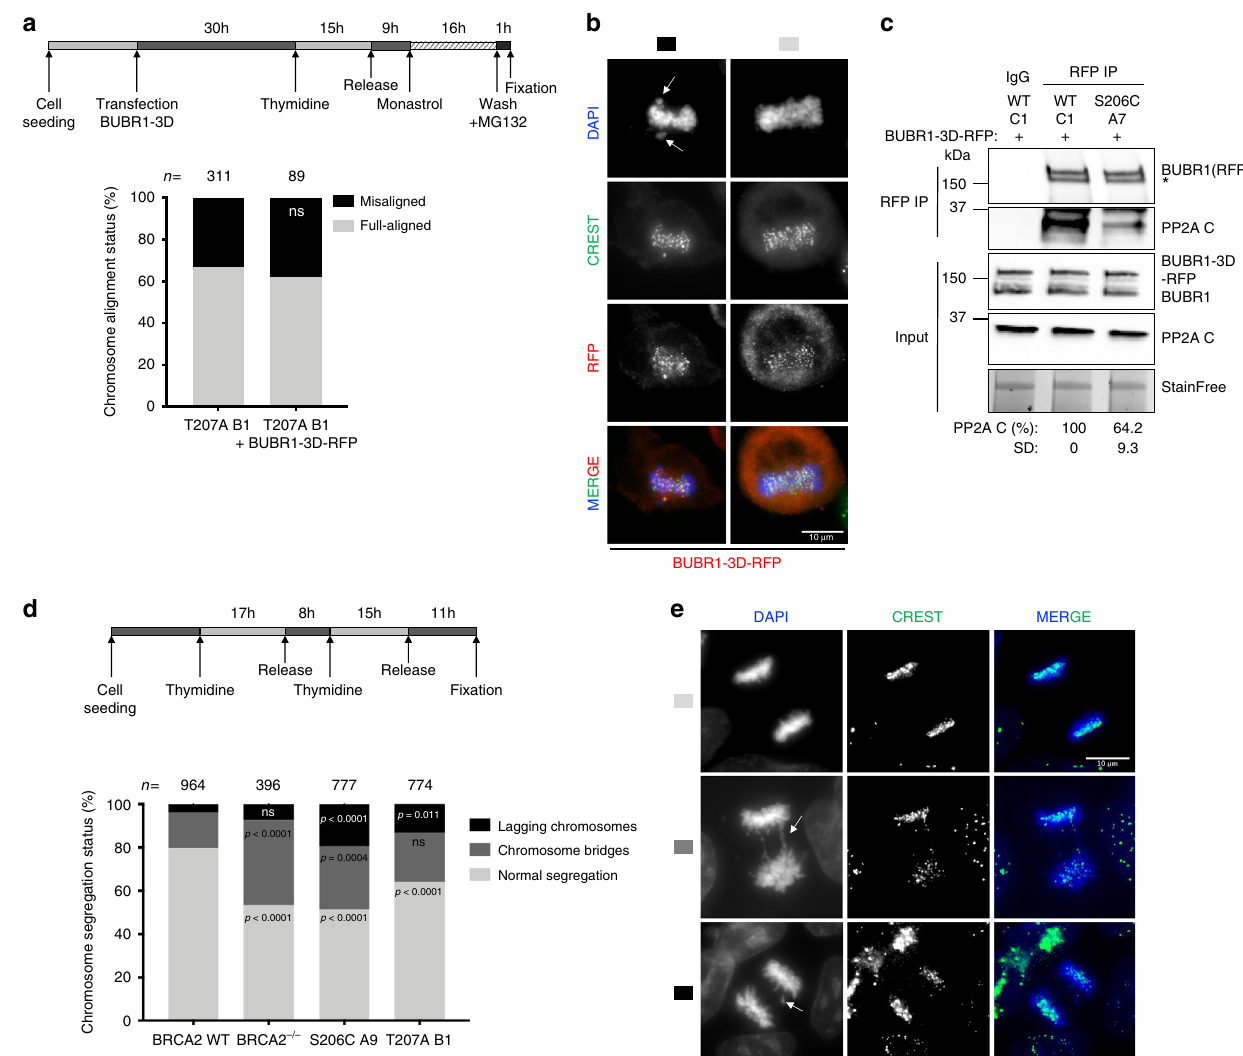
Fig. 7 Cells expressing BRCA2 variants S206C and T207A display aberrant chromosome segregation. a Top: Scheme of the synchronization procedure. Bottom: Quanti fi cation of misaligned chromosomes in BRCA2-T207A stable clones transiently overexpressing the 3xFLAG-BUBR1-3D-RFP mutant (S670D, S676D and T680D). n indicates the total number of cells counted from two independent experiments. Unpaired two-tailed t -test was used to calculate statistical signi fi cance of differences, ns (non-signi fi cant)). b Representative images of the type of chromosome alignment observed in cells overexpressing 3xFLAG-BUBR1-3D-RFP quanti fi ed in ( a ); scale bar represents 10 µ m. c Co-immunoprecipitation of endogenous PP2A with transiently overexpressed 3xFLAG- BUBR1-3D-RFP mutant from mitotic cell extracts of BRCA2 WT cells or cells bearing the S206C variant using rabbit anti-RFP antibody. Rabbit IgG was used as control for the BUBR1 immunoprecipitation. The immunocomplexes were resolved on 4 – 15% SDS-PAGE followed by WB using mouse anti-BUBR1 and PP2AC antibodies. The amount of PP2A co-immunoprecipitated with BUBR1-3D-RFP relative to the input levels of PP2A and the amount of immunoprecipitated BUBR1- 3D-RFP is presented below the blot as mean ± SD from two independent experiments. The data are presented relative to the non-treated BRCA2 WT. Asterisk denotes a non-speci fi c band ( d ). Top: Scheme of the synchronization procedure. Bottom: Quanti fi cation of cells with aberrant chromosomes segregation in BRCA2 − / − cells and in the clones stably expressing BRCA2 WT, S206C and T207A, as indicated. Two-way ANOVA test with Tukey ’ s multiple comparisons test was used to calculate statistical signi fi cance of differences (the p -values show the signi fi cant differences compared to WT; ns (non-signi fi cant)). n in ( d ) indicates the total number of cells counted for each clone from two (BRCA2 − / − , S206C and T207A) and fi ve (BRCA2 WT) independent experiments. e Representative images of the type of aberrant chromosome segregation observed in the cells quanti fi ed in ( d ), CREST antibody is used as marker of centromere; nuclei are revealed with DAPI counterstaining. Scale bar represents 10 µ m. Source data are available as a Source Data fi